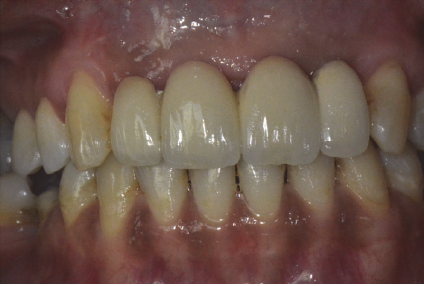
Figure 5: Suture.